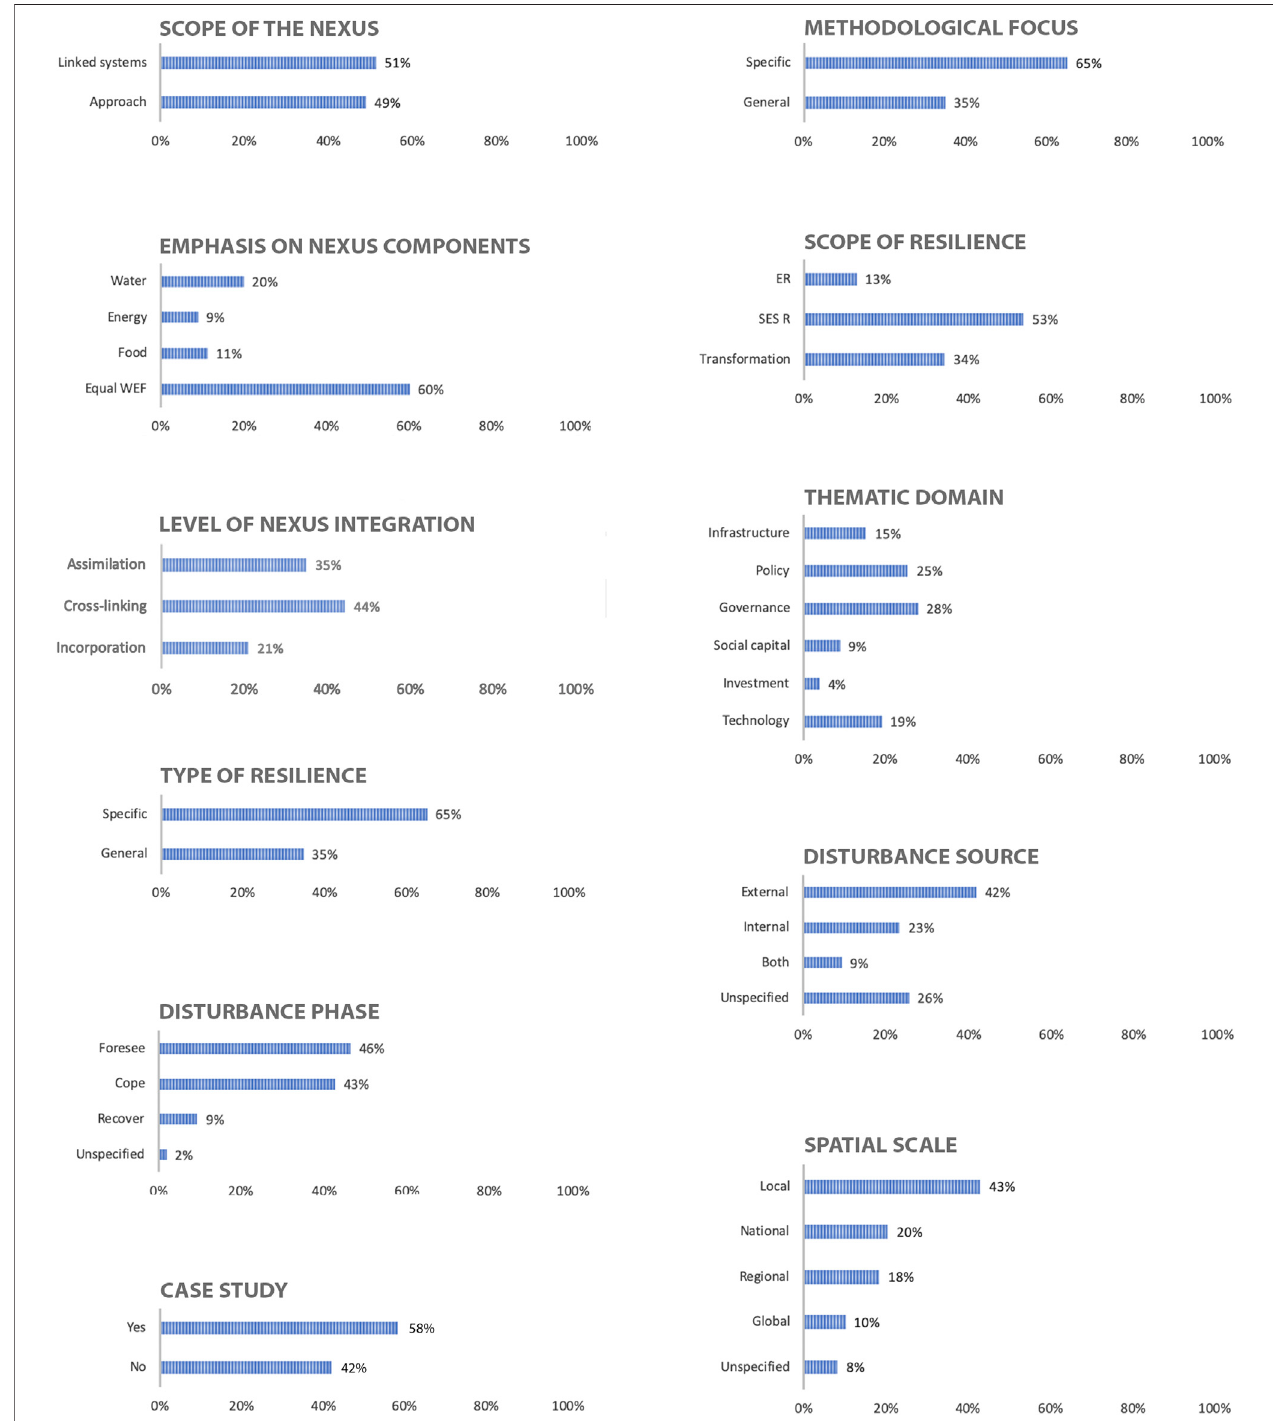
FIGURE 1 | Cross-section of the research landscape across each of the identi fi ed nexus and resilience characteristics.